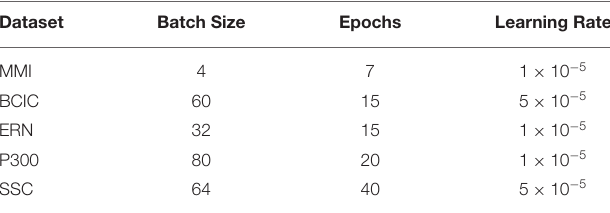
TABLE A1 | Hyperparameters that varied between datasets, and these were not changed between different model configurations (see list in section 2.4.2).